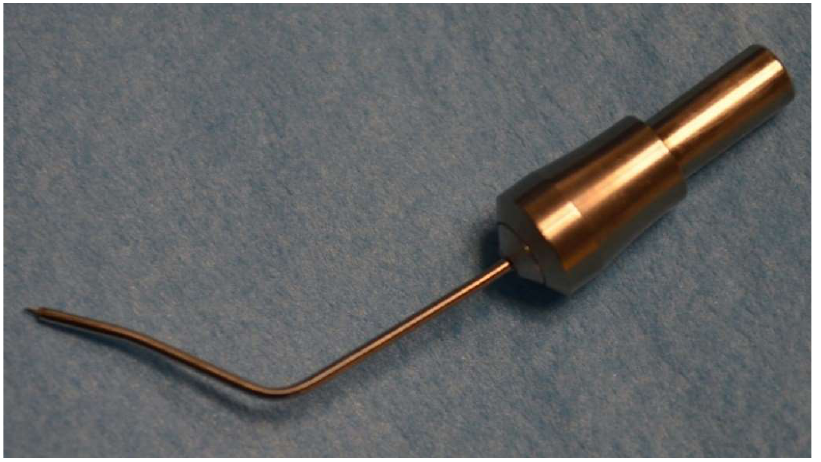
Figure 4. Abee ® (HFDS) tip.